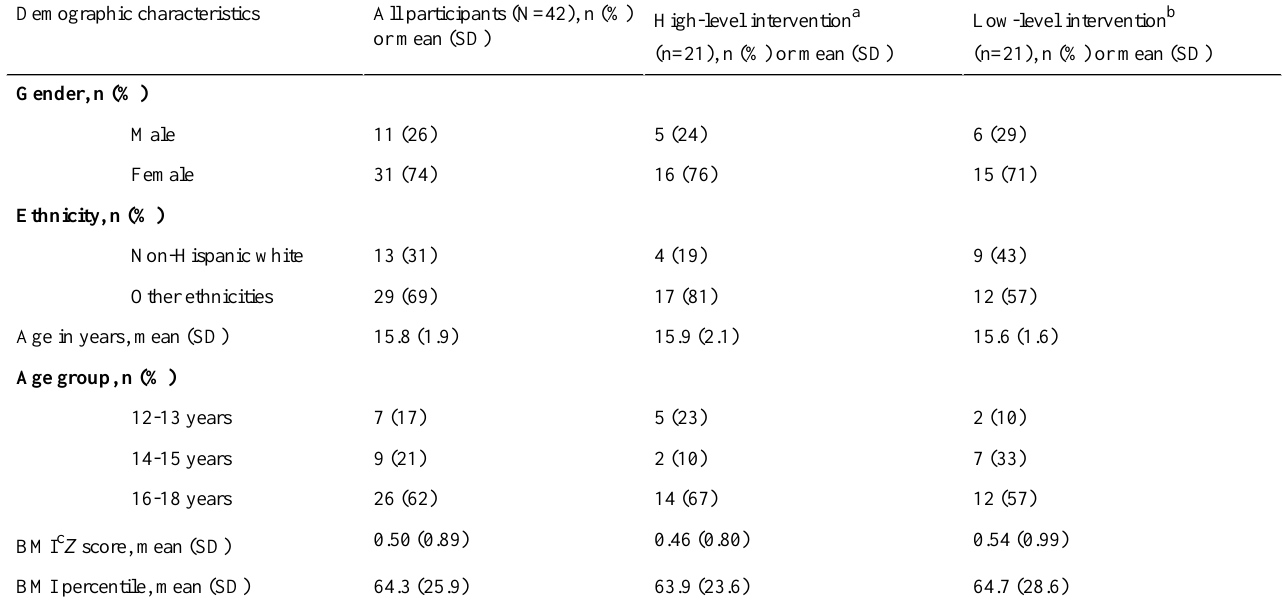
Table 1. Demographic profile of